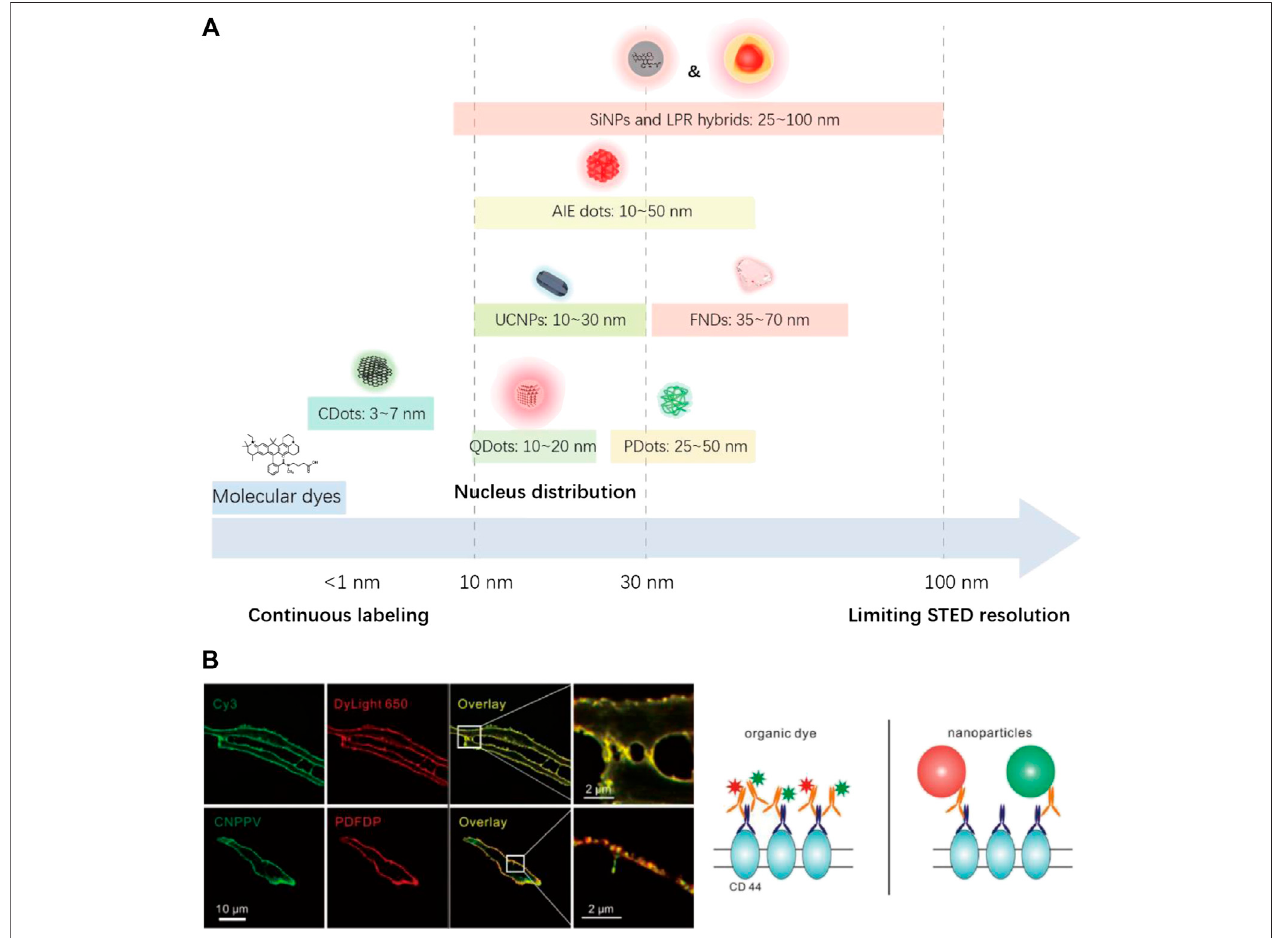
FIGURE 12 | (A) Size distribution of reported STED nanoprobes (also see Table 1 ). (B) The observation of discontinuous labeling of nanoparticles due to steric effect (Wu et al.,